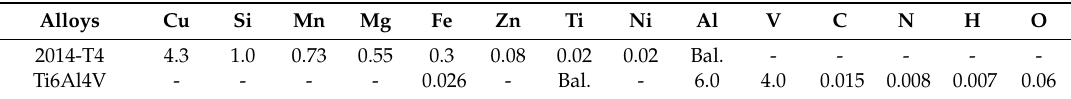
Table 1. Chemical compositions of the 2014-T4 aluminum alloy and Ti6Al4V titanium alloy (wt.%). Alloys Cu